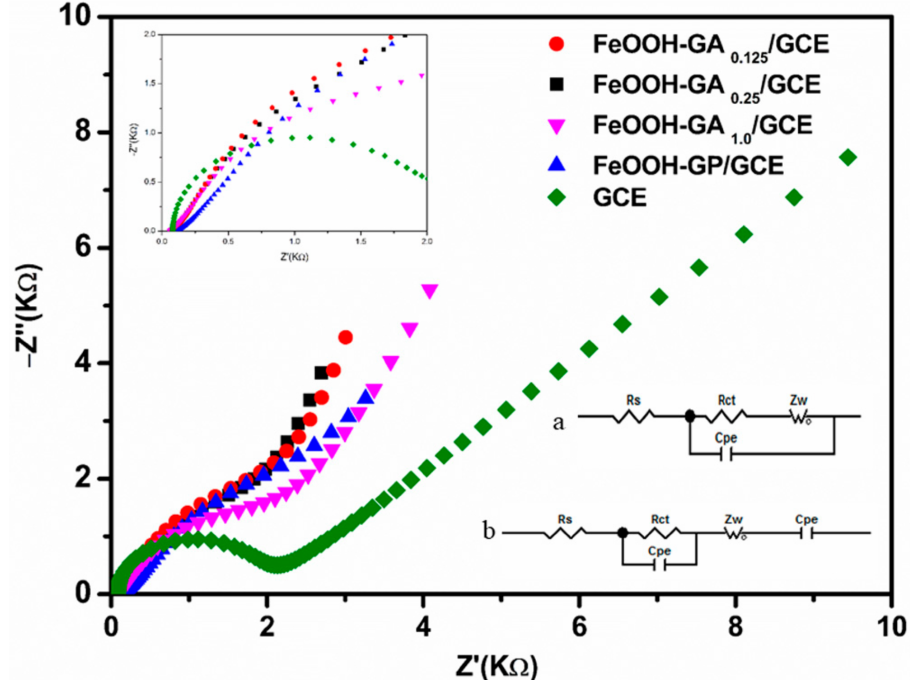
Figure 10. Electrochemical impedance spectra of GCE, FeOOH-GA 0.125 /GCE, FeOOH-GA 0.25 /GCE, FeOOH-GA 1.0 /GCE and FeOOH-GP/GCE. The right inset is the equivalent circuit of GCE (a) and FeOOH-GA 0.125 /GCE, FeOOH-GA 0.25 /GCE, FeOOH-GA 1.0 /GCE and FeOOH-GP/GCE (b). The left inset is the Nyquist polts of all working electrodes in the high frequency